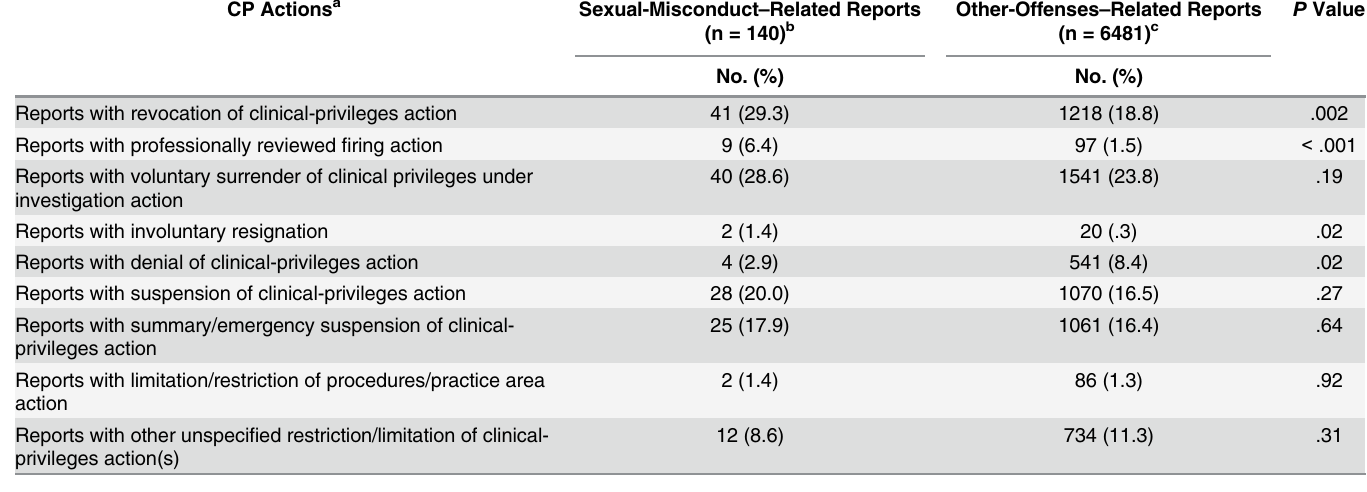
Table 5. Adverse Clinical-Privileges Actions Taken Against Physicians in Sexual-Misconduct – Related vs Other-Offenses – Related Physician Clini- cal-Privileges Reports (Report-Level